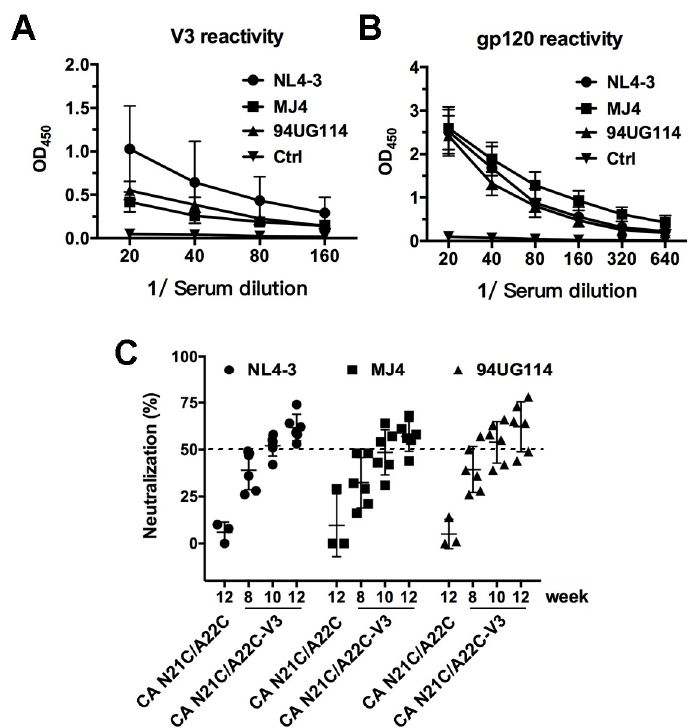
Figure 5. Immunogenicity of CA N21C/A22C-V3. ( A and B ) The reactivity of antiserum against V3 peptides ( A ) and gp120 proteins ( B ) from NL4-3 (clade B), MJ4 (clade C) and 94UG114 (clade D), as measured by ELISA. Pre-immune sera served as a control. ( C ) Neutralization assay of antiserum using HIV-1 NL4-3, MJ4 and 94UG114 viruses. Serum from the immunization of CA-N21C/A22C particle (week 12) served as a control. Data are the mean and standard deviations. All experiments were repeated three